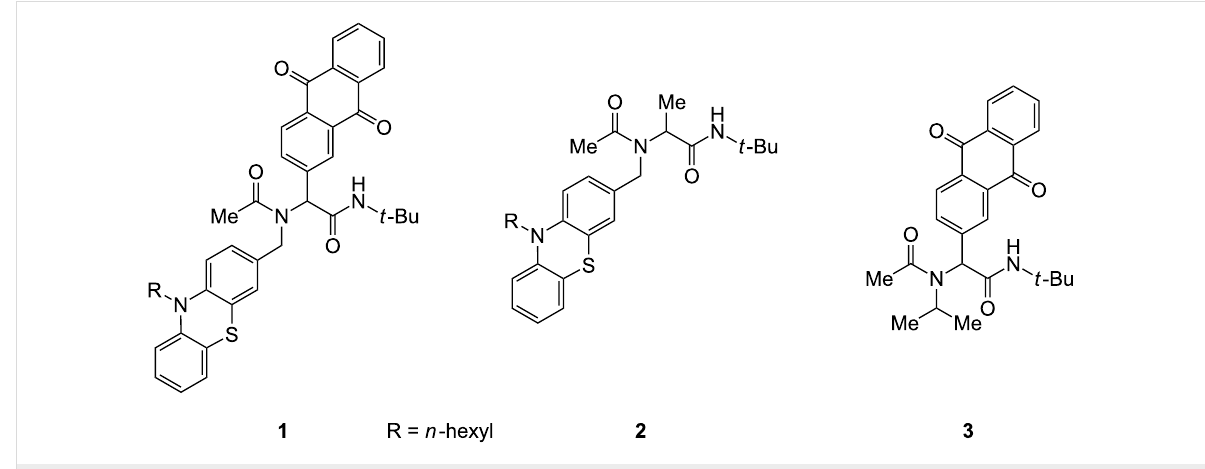
Figure 1: Phenothiazine–anthraquinone dyad 1 , donor-only ( 2 ) and acceptor-only ( 3 ) models assembled by Ugi